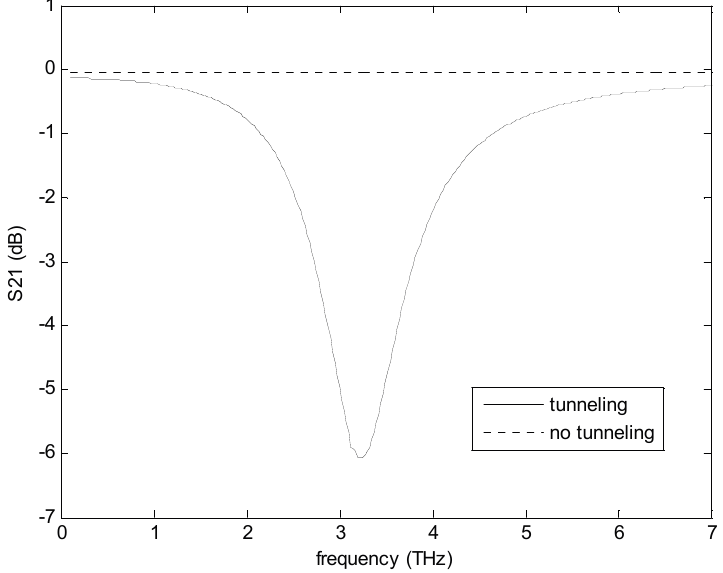
| ( ω ) | S for GNR lines with matched loads, in the 21